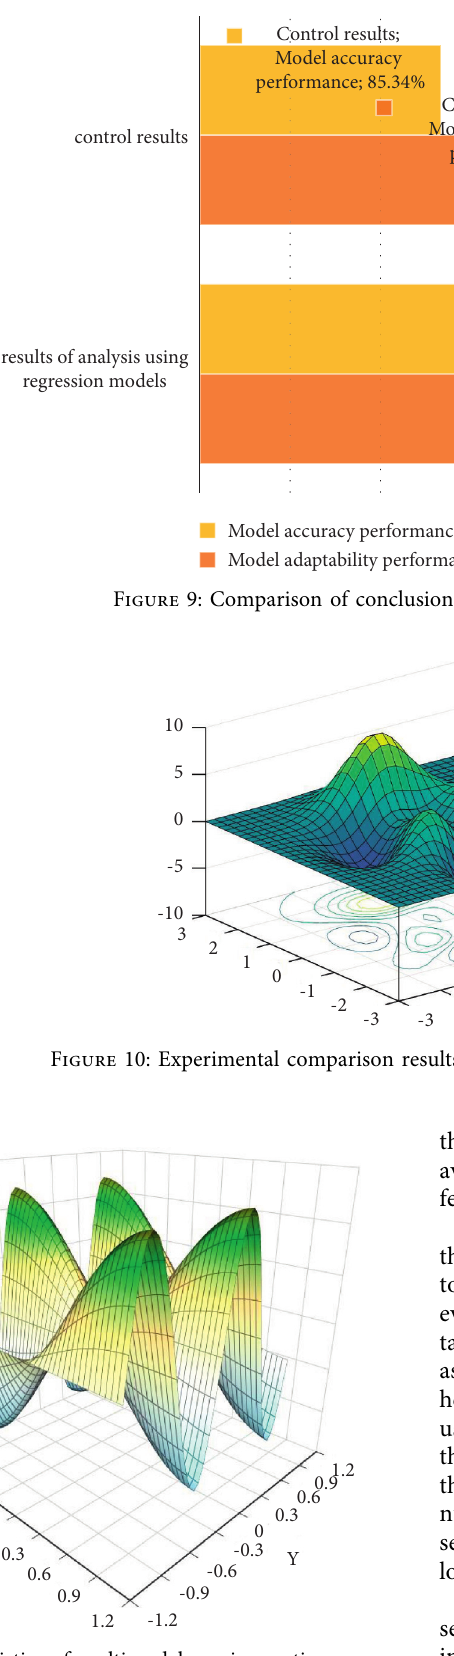
Figure 11: Result statistics of multimodal music emotion recog- nition experiment